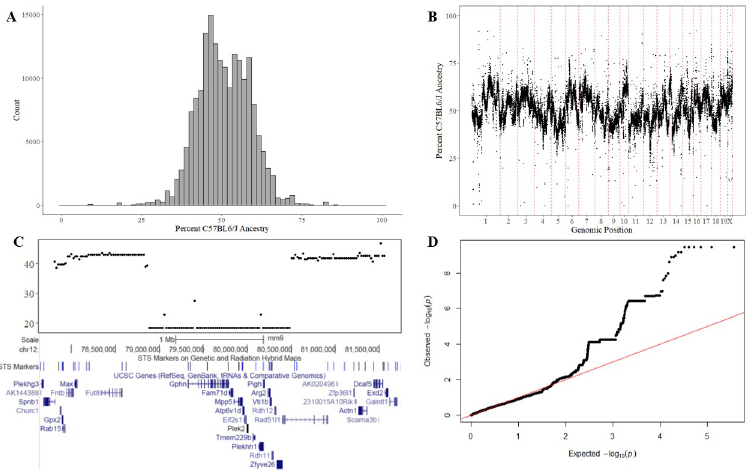
Fig 4. Allelic frequency imbalances of individual sites across the genome. A) A histogram of B6 ancestry across the geneome. B) Genome-wide plot of ancestry C) Zoomed in region on chr 12 with significant depletion of B6 allele. D) QQ plot of all Pvalues calculated by a Wald test. Genomic Inflation Factor λ = 1.07.